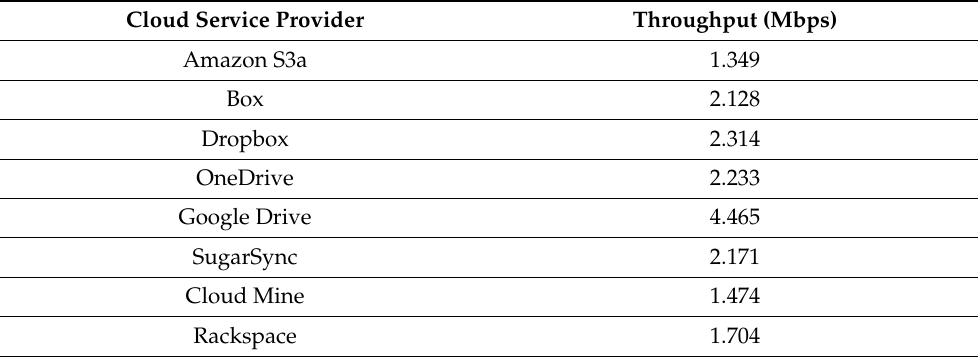
Table 4. Different cloud service providers’ throughput [52]. Reproduced from [52], the name of the publisher: Wiley Online